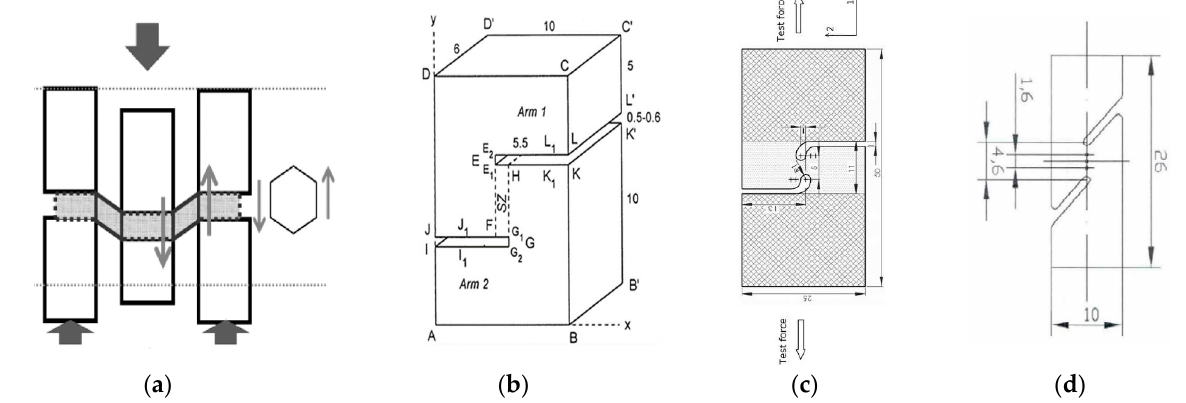
Figure 7. The different ways to directly apply simple shear that have been proposed in the literature: ( a ) a specimen with a double shear zone [74]; ( b ) a double-notch specimen in compression mode [70,71] (SZ is the zone of shear); ( c ) a double-notch tensile–shear specimen [75]; ( d ) a tilted double-notch tensile–shear specimen [76,77].